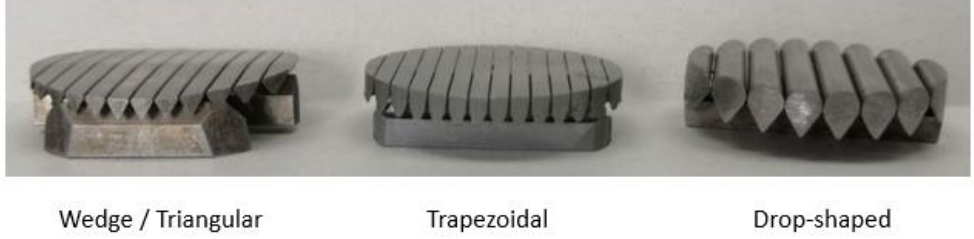
Figure 3. Wire-wrapped screens with different wire profiles [by authors] (wires are welded to elements of longitudinal supporting ribs).